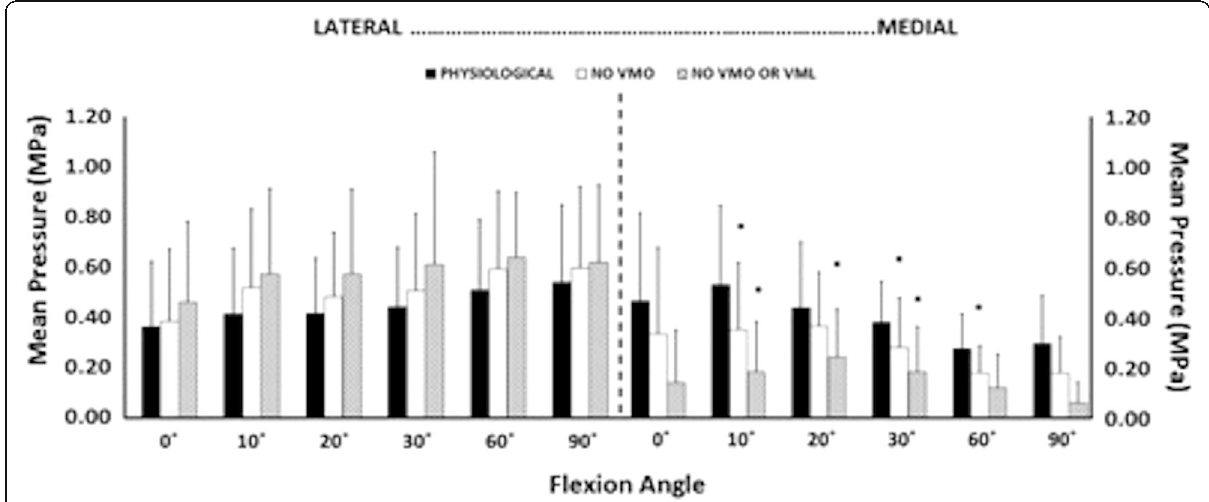
Fig. 4 Mean contact pressures for lateral and medial facets, across 0 to 90° knee flexion, showing efffects of relaxing the VMM. * p <